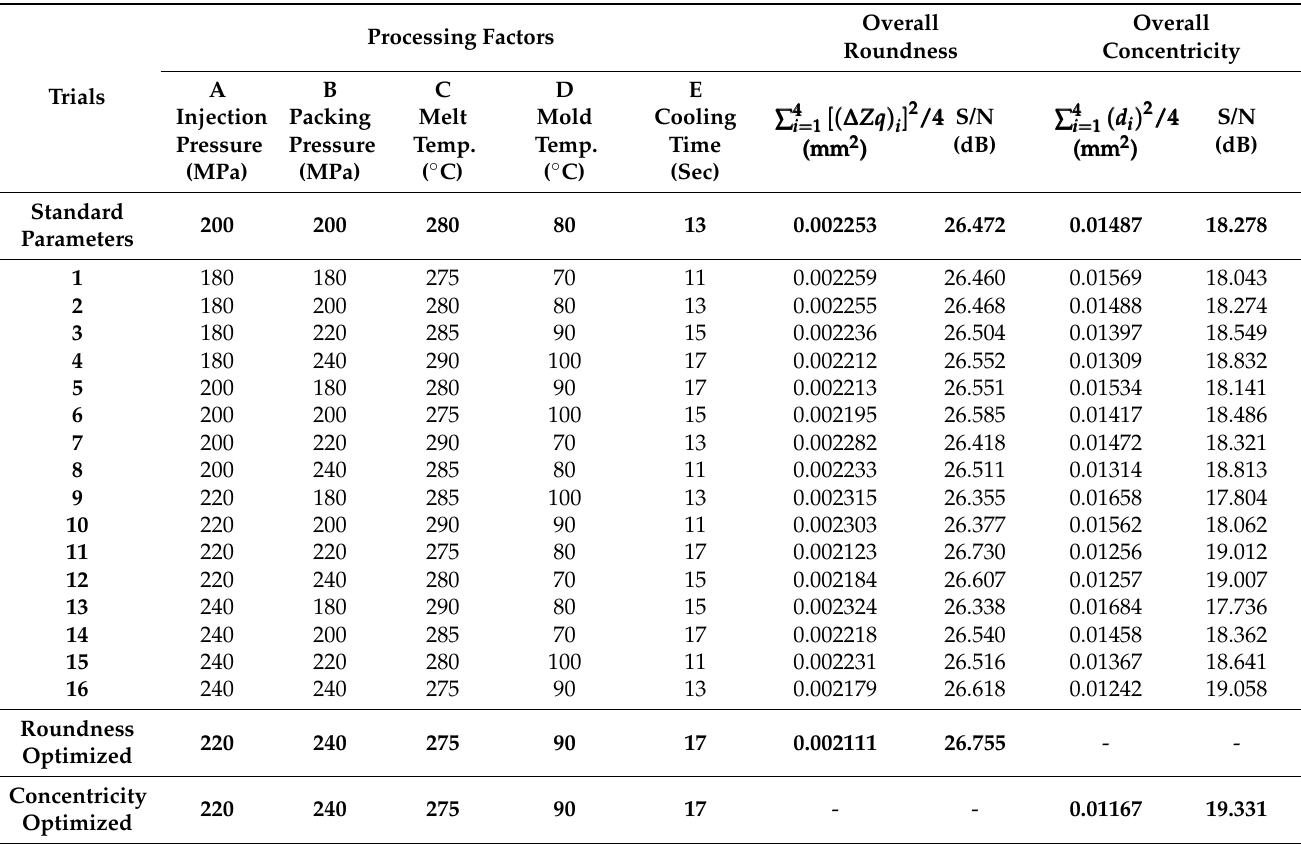
Table 3. Taguchi analysis results for overall roundness and overall